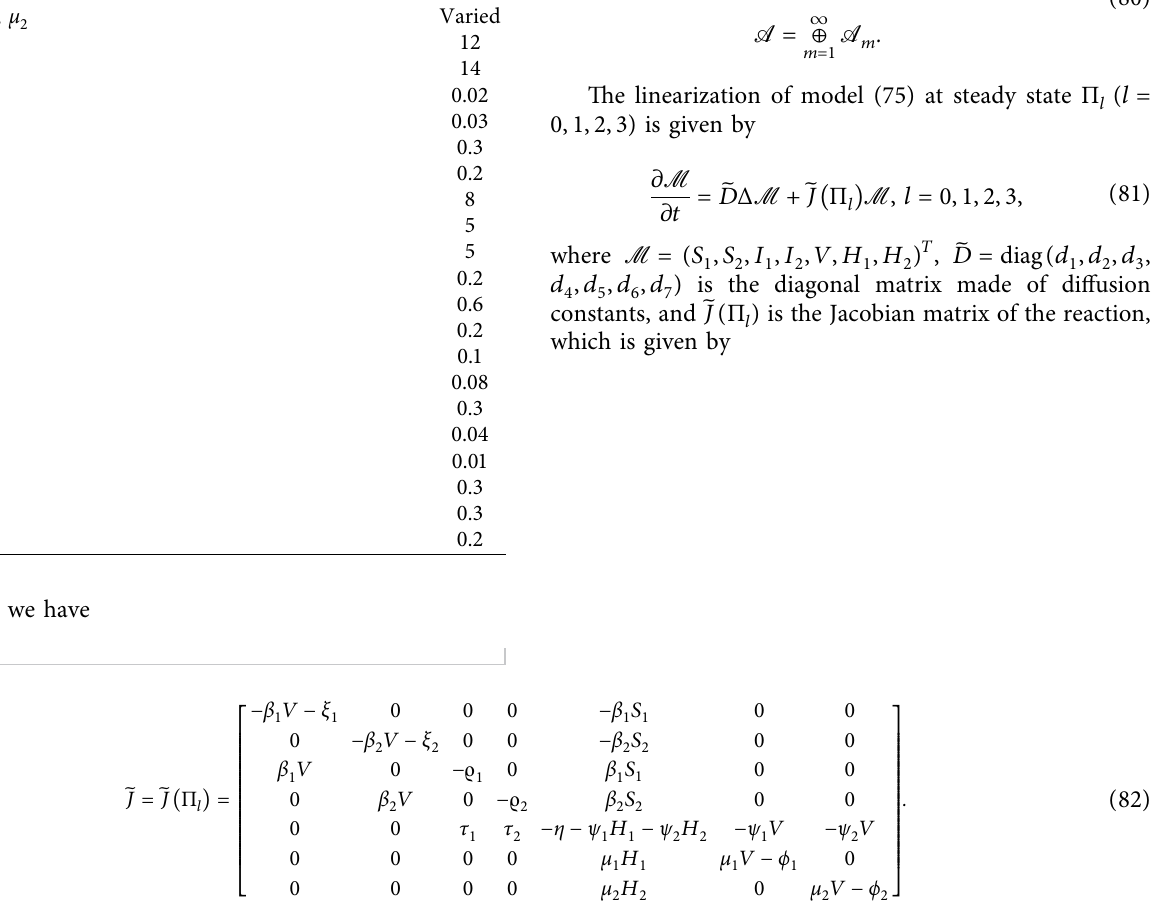
Table 2: Te values of the parameters of system (75) ([25, 26, 48]).